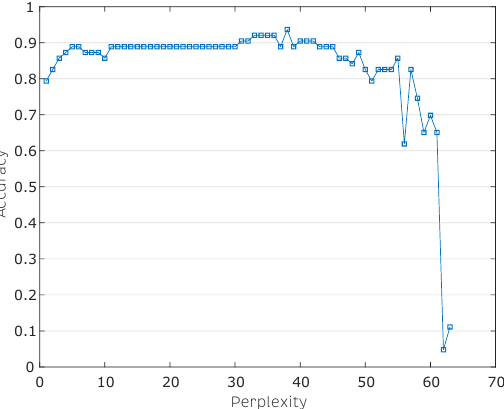
Figure 7. Effect of the perplexity parameter variation belonging to the algorithm t -Stochastic Neighbor Embedding (SNE) on the classification accuracy.